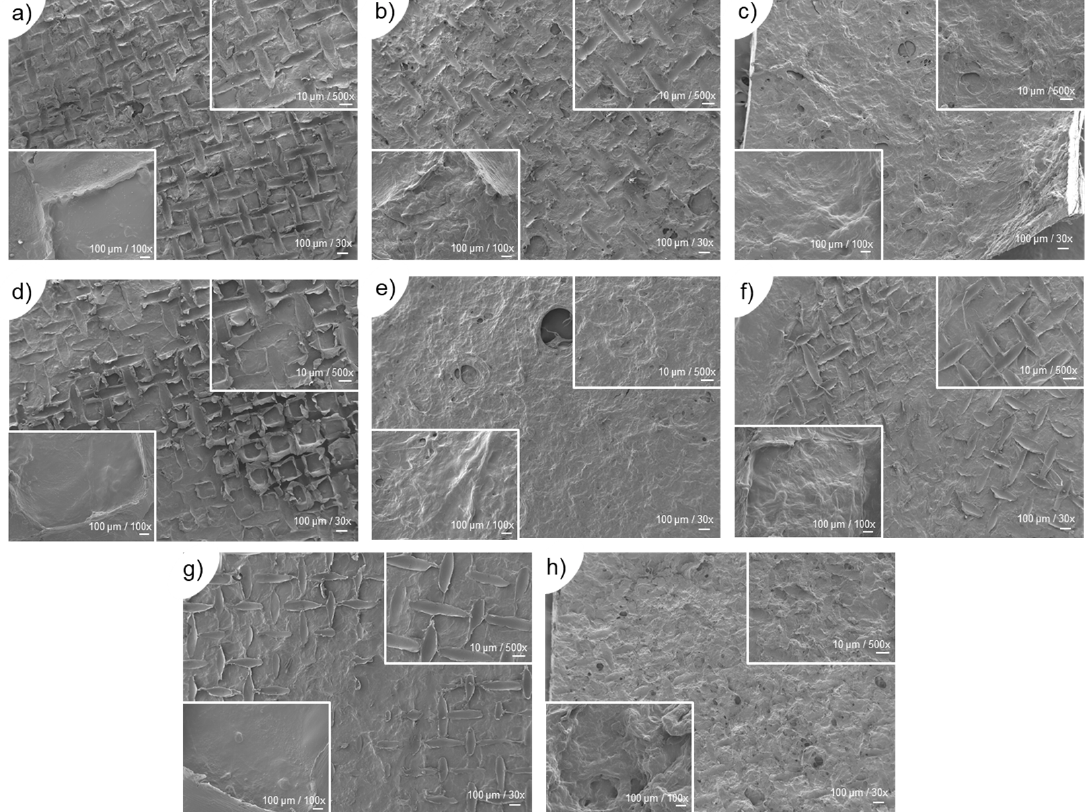
Figure 5. Scanning electron microscopy (SEM) images of the surface of all developed membranes (M/J3 to M/J5S5) according to the established formulations, ( a – h ), respectively. All samples were imaged at the magni fi cations of 30×/100 µm ( main ), 100×/100 µm ( bo tt om left ) and 500×/10 µm ( top right ).